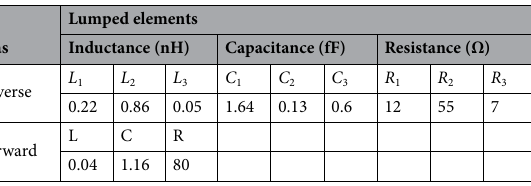
Lumped elements Bias Inductance